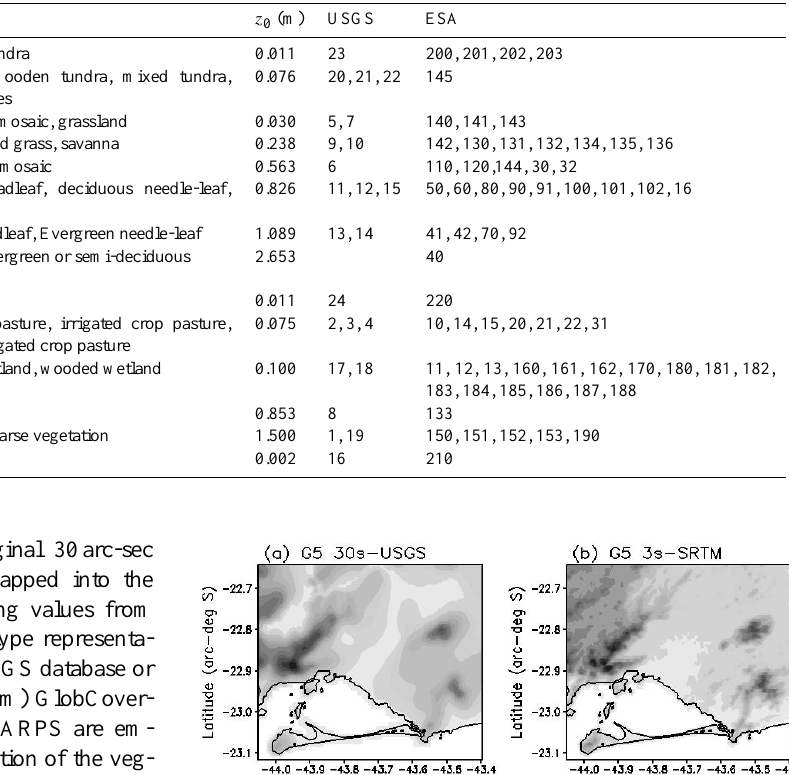
Table 3. Conversion of the original 30arc-sec USGS and updated 10arc-sec ESA categories of vegetation type to the USDA classification that is adopted by ARPS. See tables in Xue et al. (1995) and Bicheron et al. (2008), and the user guide for more information on the vegetation-type categories.